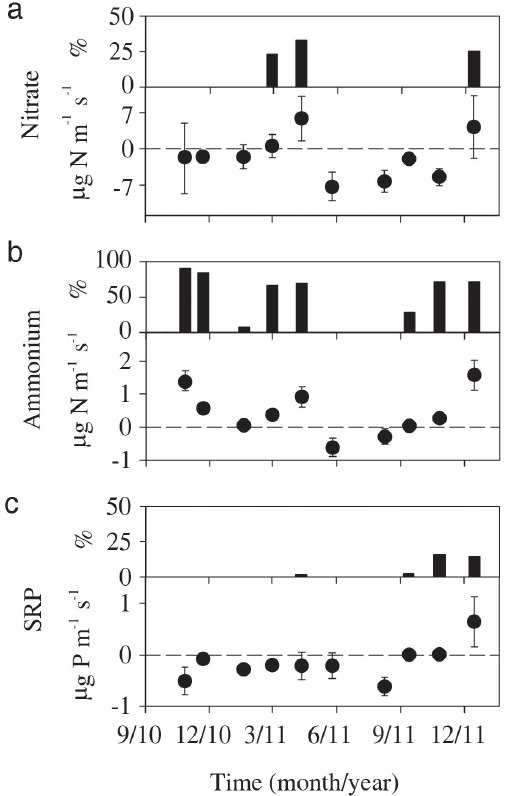
Figure 7. Temporal pattern of in-stream net nutrient uptake ( F sw , in µgm − 1 s − 1 ) for (a) nitrate, (b) ammonium, and (c) soluble reac- tive phosphorus at the whole-reach scale. Whiskers are the uncer- tainty associated with the estimation of stream discharge from slug tracer additions. F sw > 0 indicates that gross uptake prevailed over release, while F sw < 0 indicates the opposite. For those cases for which F sw > 0, the contribution of in-stream net nutrient uptake to reduce stream nutrient fluxes ( F sw × x/F in , in %) is shown (black